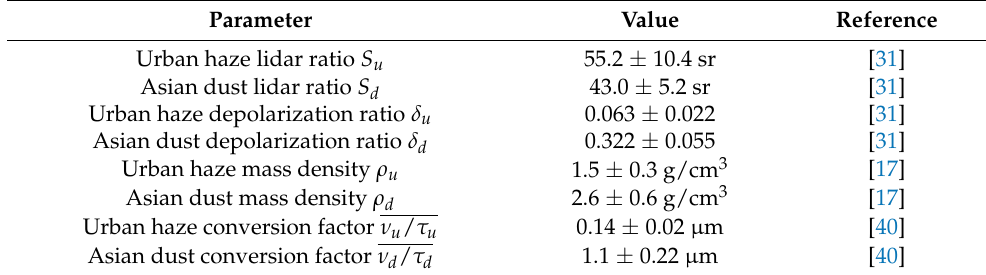
Table 1. Input parameters in dust and urban haze mass concentrations